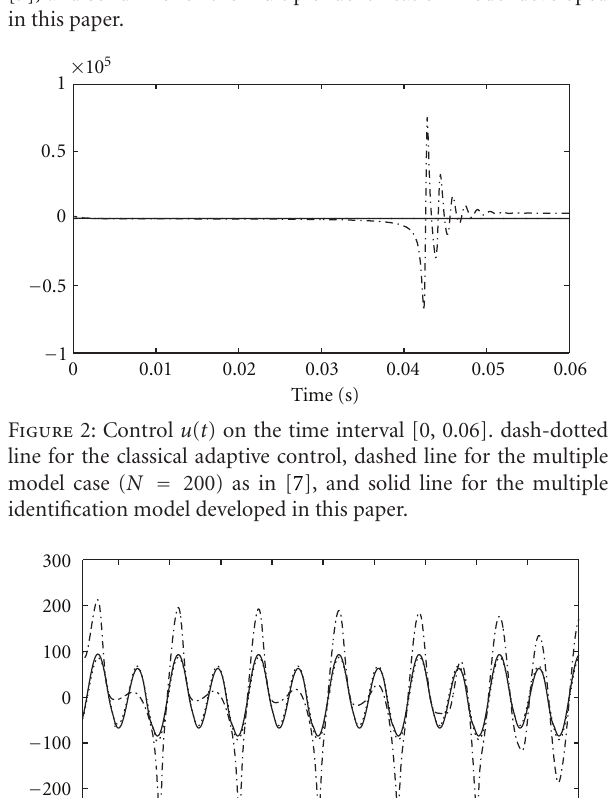
Figure 6: Control u ( t ) on the time interval [0, 0.06]. dashed line for the multiple model case ( N = 4) in [7], and solid line for the multiple model developed in this